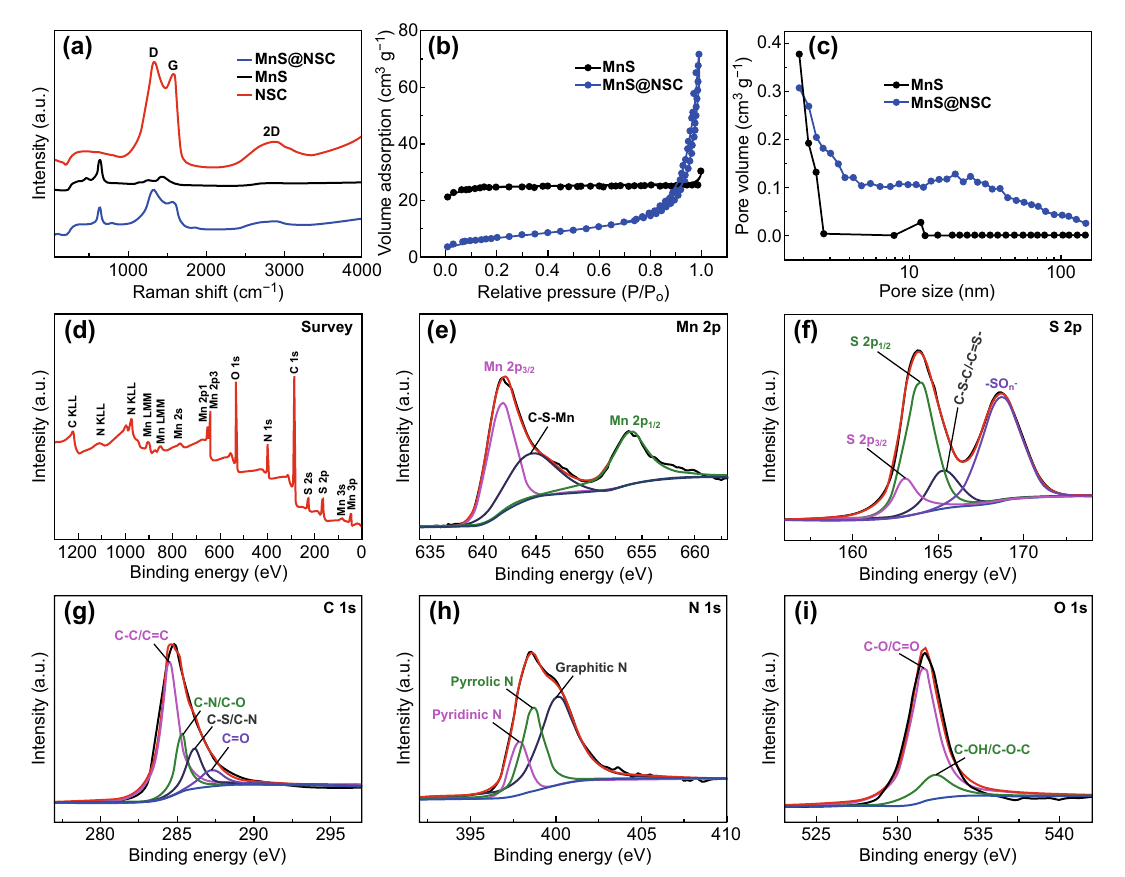
Fig. 2 a Raman spectra of NSC, MnS, and MnS@NSC. b N 2 adsorption/desorption isothermal curves and c pore size distribution profiles of MnS and MnS@NSC. d Typical XPS survey spectrum and corresponding e Mn 2 p , f S 2 p , g C 1 s , h N 1 s , and i O 1 s spectra of MnS@NSC